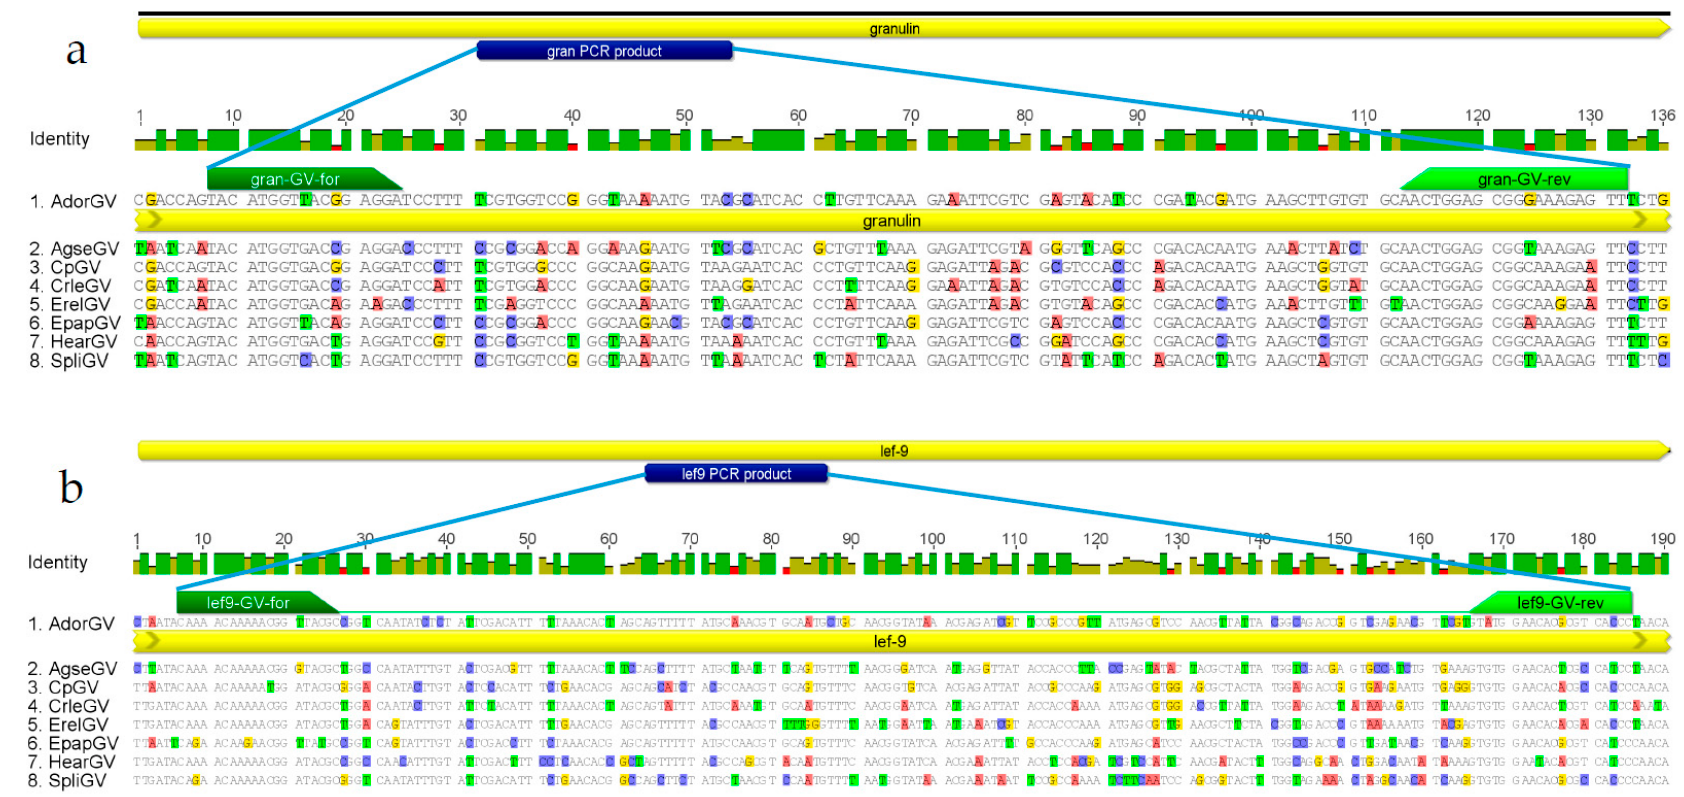
Figure 2. The nucleotide alignments of fragments of gran ( a ) and lef-9 ( b ) from eight granuloviruses used in this study. Blue rectangles show localization of short fragments in the analyzed genes. Primer localization is marked in green. Colorful bases indicate mismatches in the alignments.